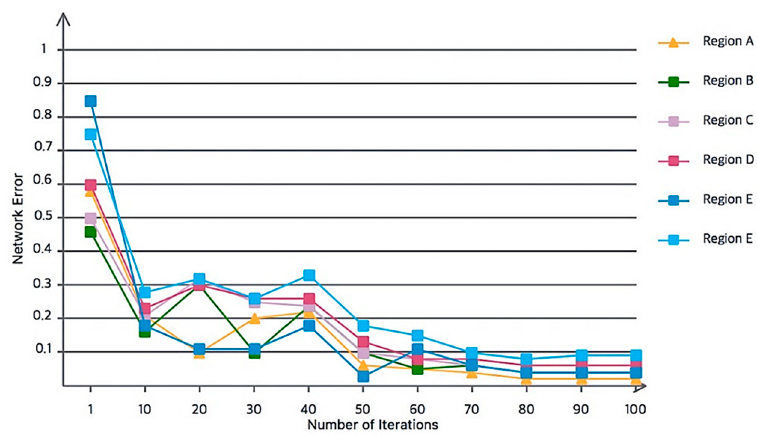
Figure 8. The proposed network error for all regions for validation data.